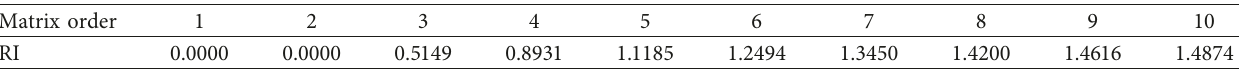
Table 5: Values of RI.